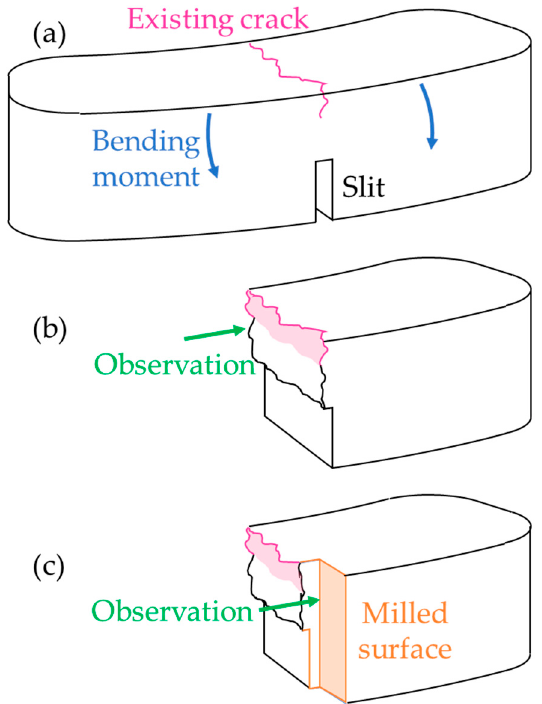
Figure 5. Procedure for investigating crack characteristics: ( a ) Position of the breaking slit; ( b ) observation of the crack face; ( c ) milling enabling the observation of the material near the crack.